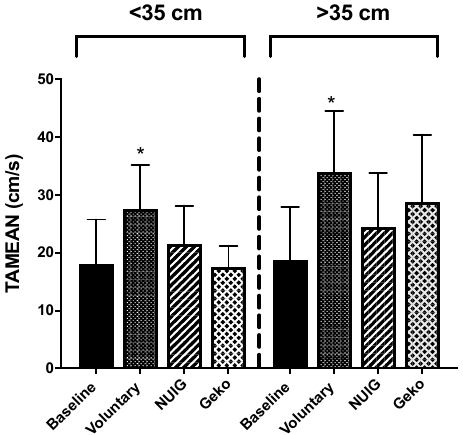
Figure 7. Effect of calf muscle circumference on the ejected volume. For a calf muscle circumference of both < 35 and >35 cm, only voluntarily contraction ( n = 10) showed a significant increase in comparison to baseline ( n = 10). There was no alteration in NUIG ( n = 5) and Geko device ( n = 3–4). (* P < 0.05 versus baseline). Data shown as ± SD.